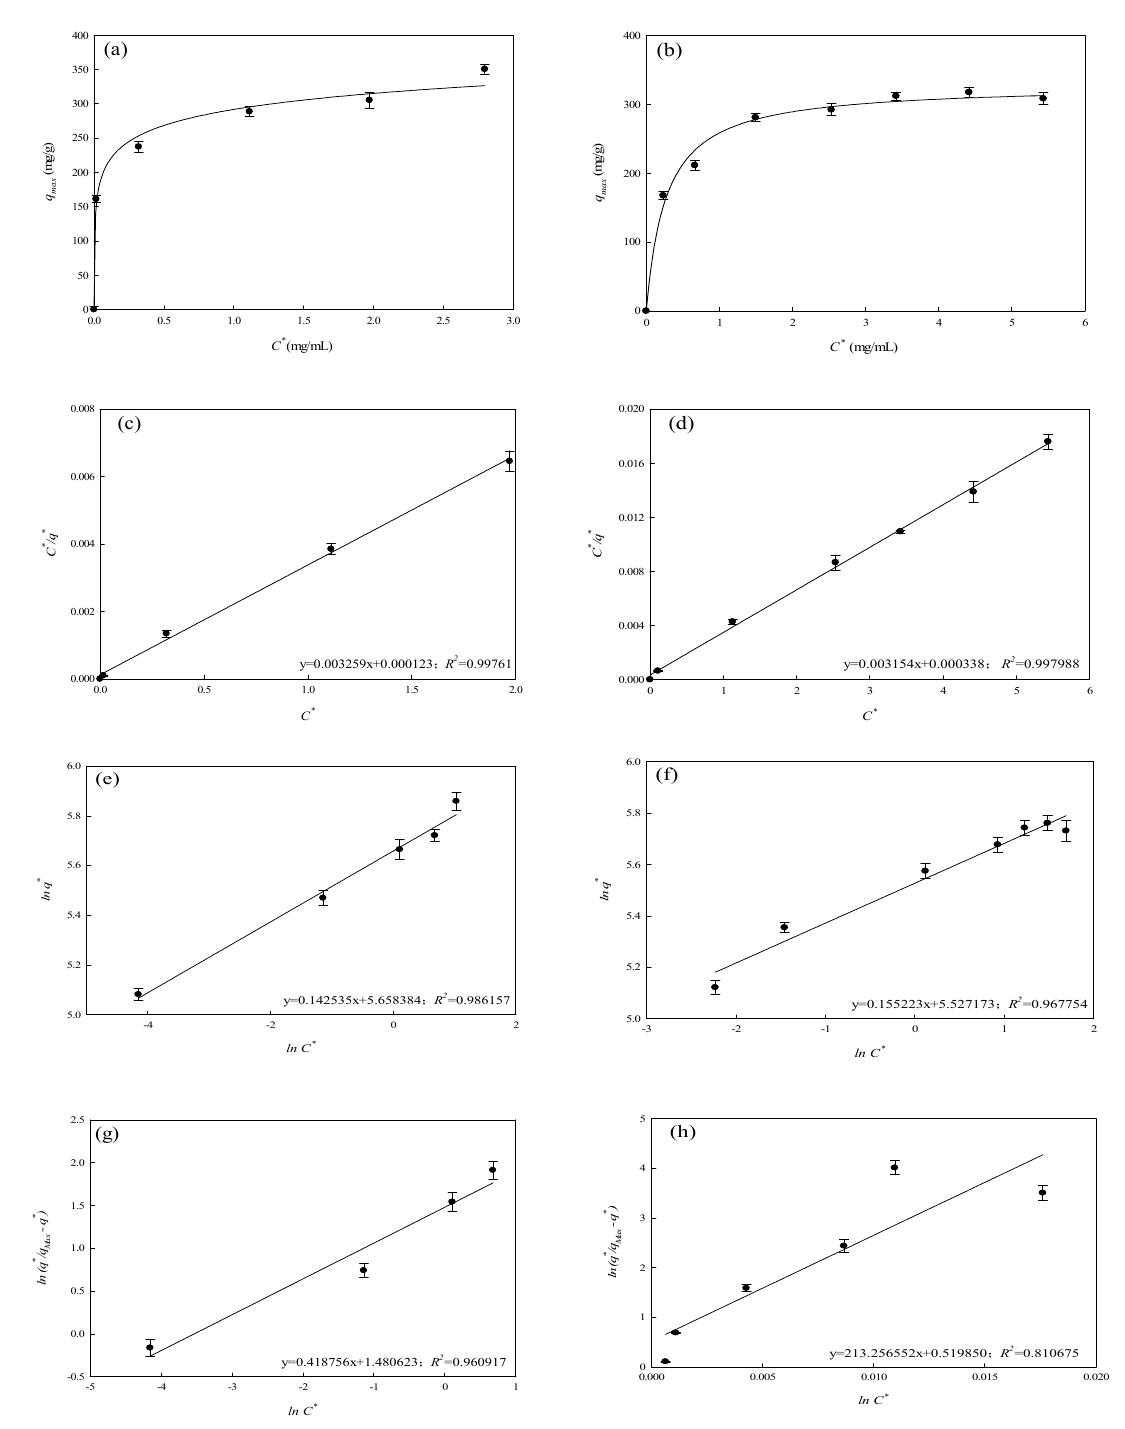
Figure 8. Equilibrium adsorption isotherms for ( a , c , e , g ) AO7 and ( b , d , f , h ) TBO on P-COOH-CS-CEW nanofiber membrane. Equilibrium adsorption isotherms fitted by Langmuir model ( c , d ), Freundlich model ( e , f ), and Langmuir–Freundlich model ( g , h ). Table 1. Equilibrium and thermodynamic parameters calculated using equilibrium isotherm mod- els for determining the adsorption behavior of P-COOH-CS-CEW nanofiber membrane for AO7 and TBO.